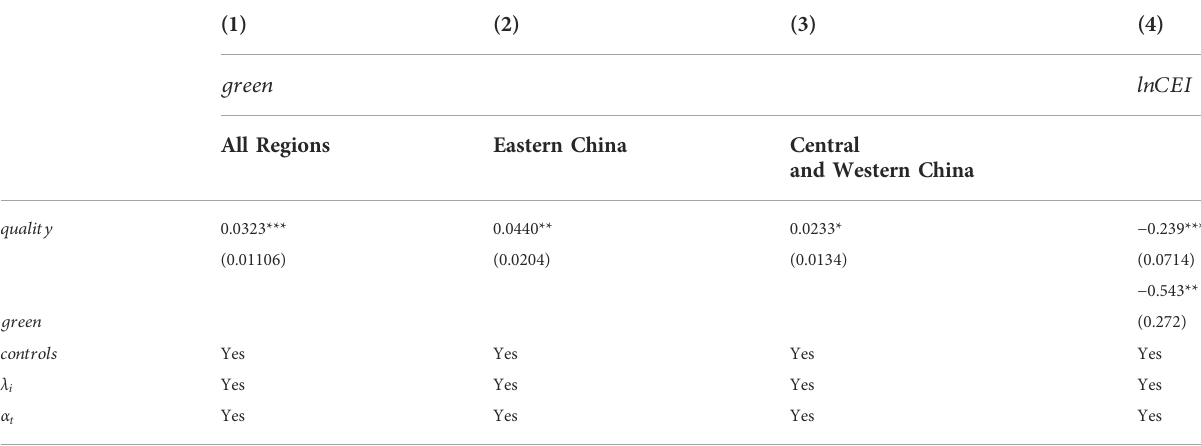
TABLE 7 Technique